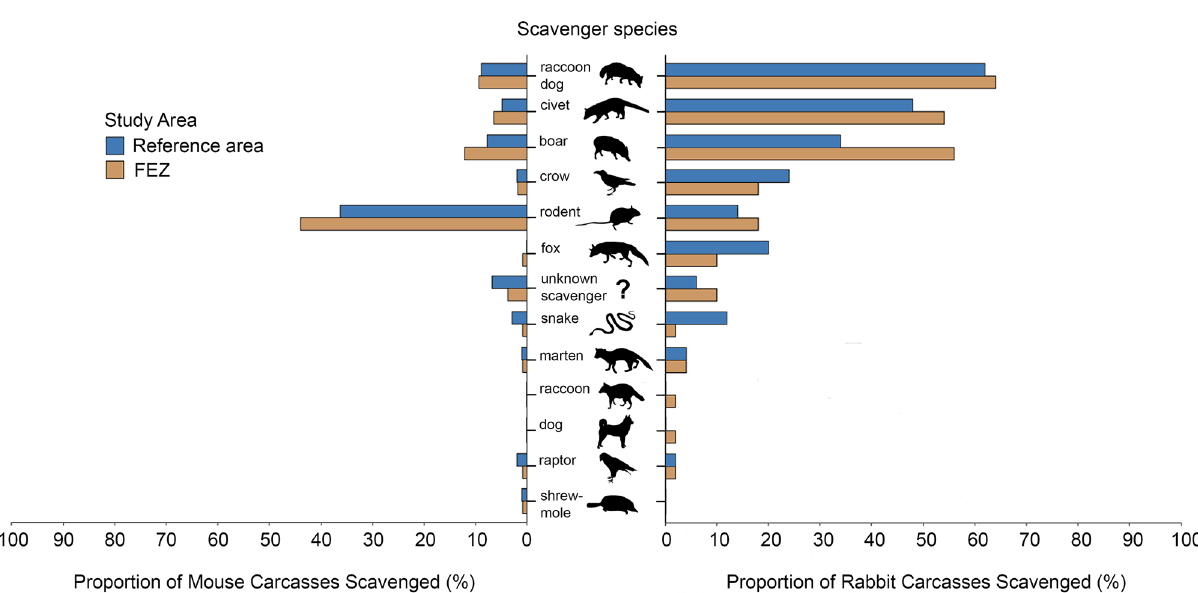
Figure 3. Proportion of experimentally placed mouse carcasses (n = 209) and rabbit carcasses (n = 100) partially or fully scavenged by different vertebrate scavengers in the Fukushima Exclusion Zone (FEZ) and inhabited reference area during May–July